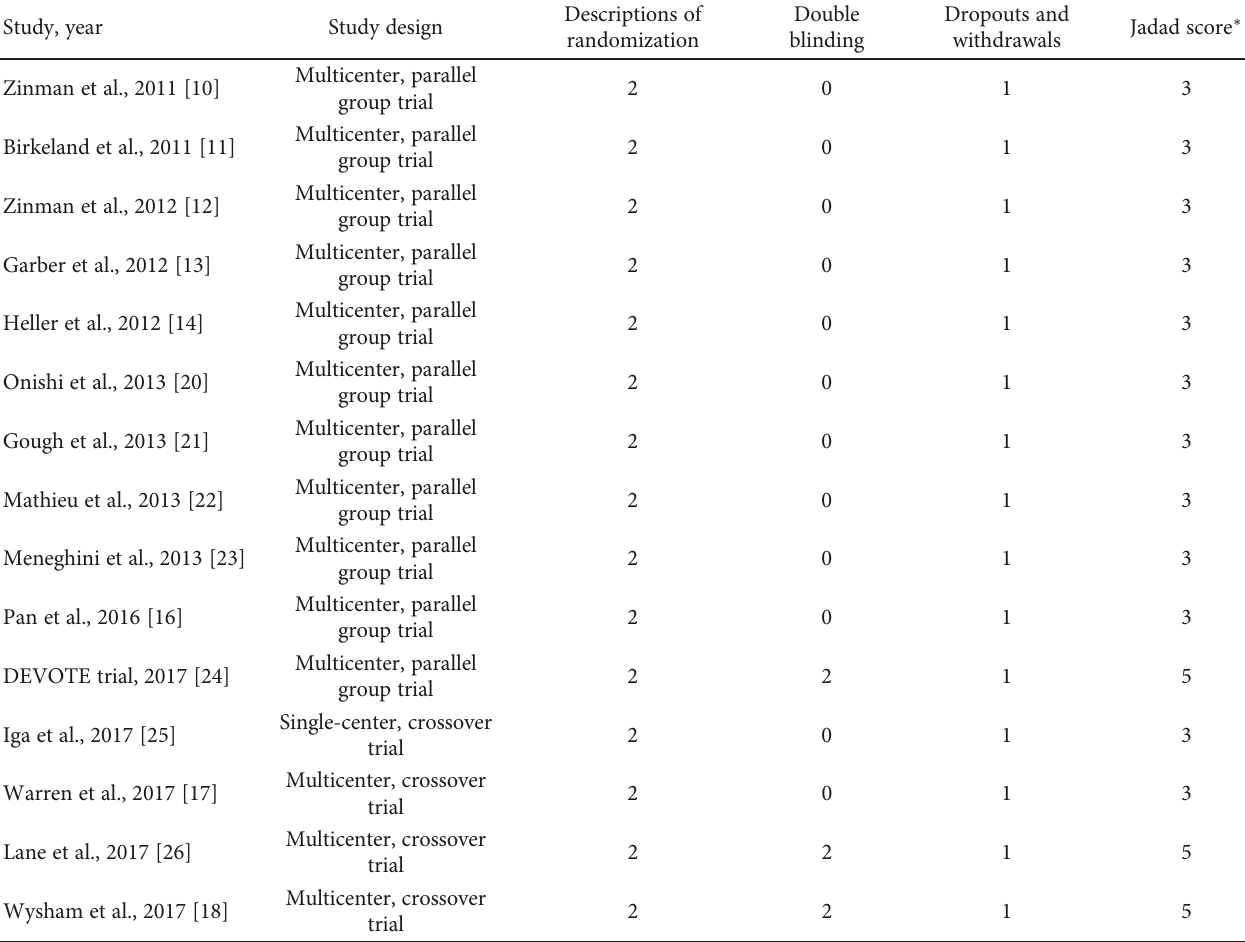
Table 3: The design and quality assessment of individual